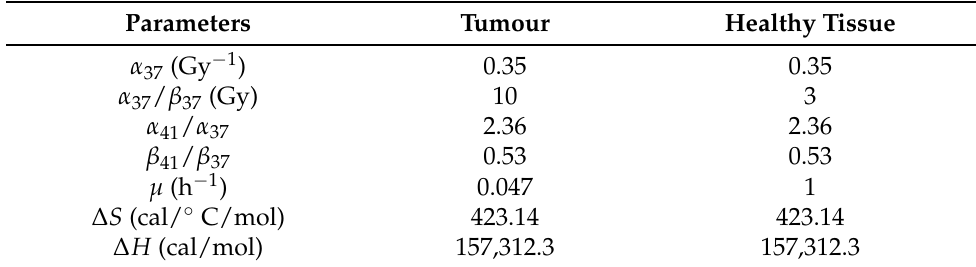
Table 2. Parameters for the model in Equation